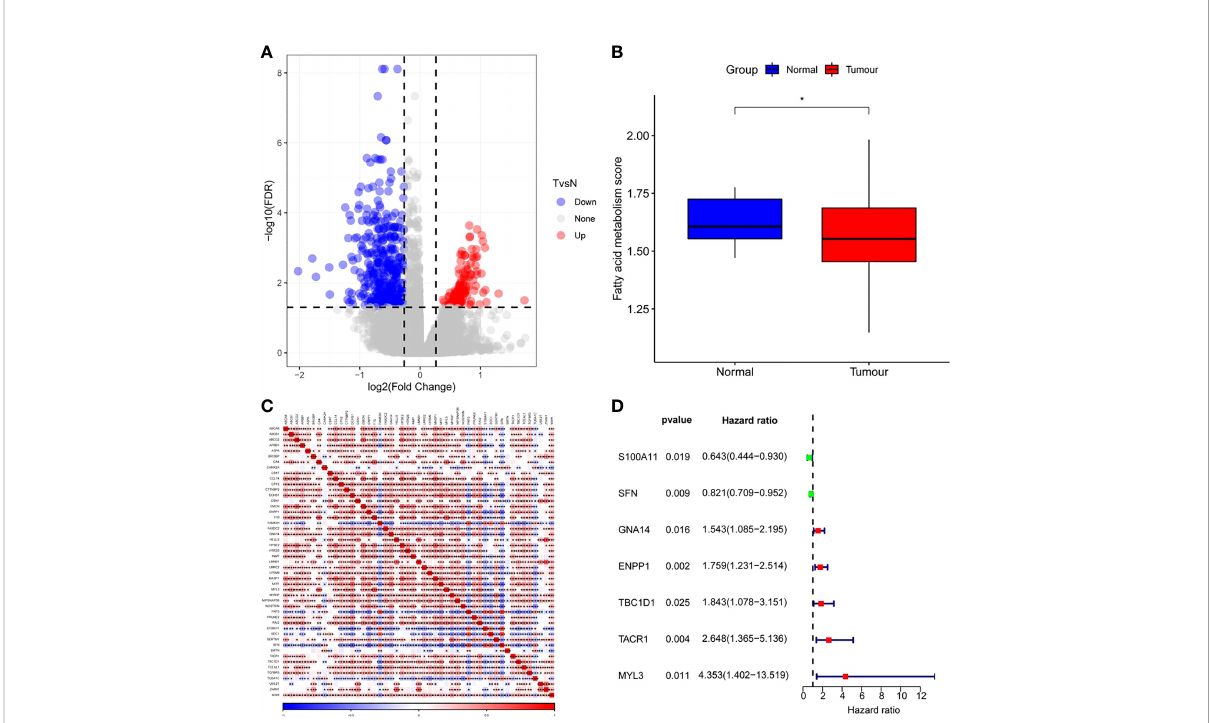
FIGURE 3 Screening of fatty acid metabolism-related genes (FAMRGs) (A) Volcano map of variation analysis between CC samples and normal samples; (B) Comparison of fatty acid metabolism-related scores (FAMRs) between CC samples and corresponding normal samples; (C) FAMRGs-related Heat map, (D) Forest map of prognosis-related FAMRGs. * vs p<0.05. *p<0.05,**p<0.01,***p<0.001.